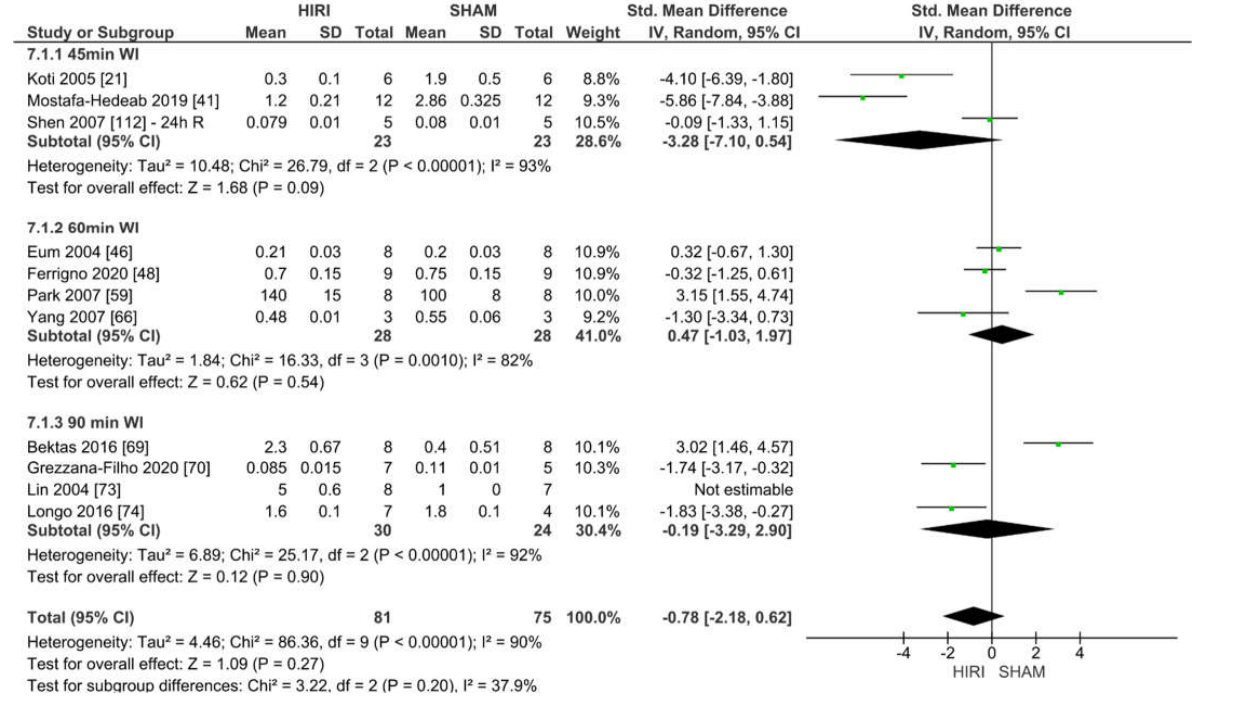
Figure 13. Forest plot of eNOS detection in SHAM versus HIRI grouped by different warm ischae- mia durations.